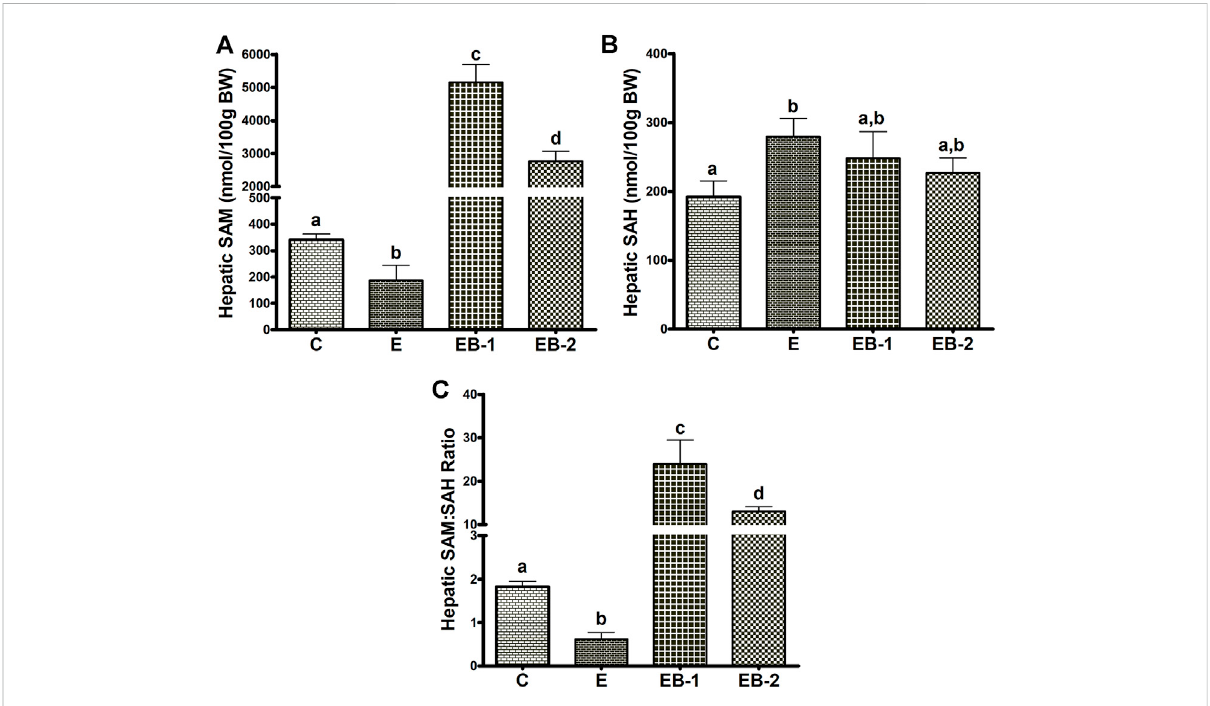
FIGURE 4 Hepatocellular SAM, SAH, and SAM:SAH ratio. (A) SAM, (B) SAH and (C) the calculated SAM:SAH ratio in livers of mice gavaged with saline [C], ethanol[E],orgivenbetaine2 hbefore[EB-1]orsimultaneouslywiththeethanolbinges[EB-2].Dataarepresentedasthemean±SEM( n =5);values not sharing a common letter signi fi cantly differ from each other at p ≤